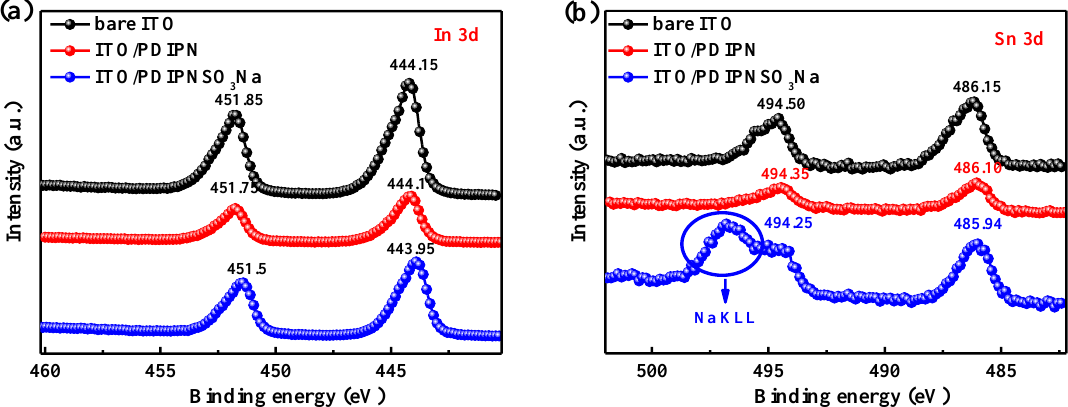
Figure 4. Survey X-ray photoelectron spectra of bare ITO, ITO/ PDIPN and ITO/ PDIPNSO 3 Na ( a ) In 3d and ( b ) Sn 3d.